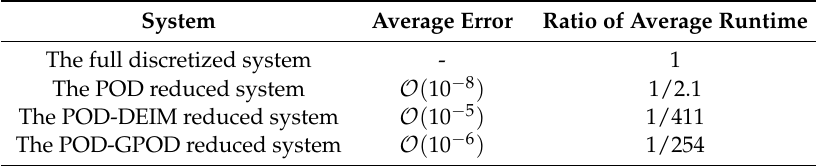
Table 6. [Test 2] The ratio of the average runtime of these systems to the runtime of the full discretized system with parameter values (cid:101) = 0.2, 0.5, and 0.8, using k = 50, m = 40 and q = 70.